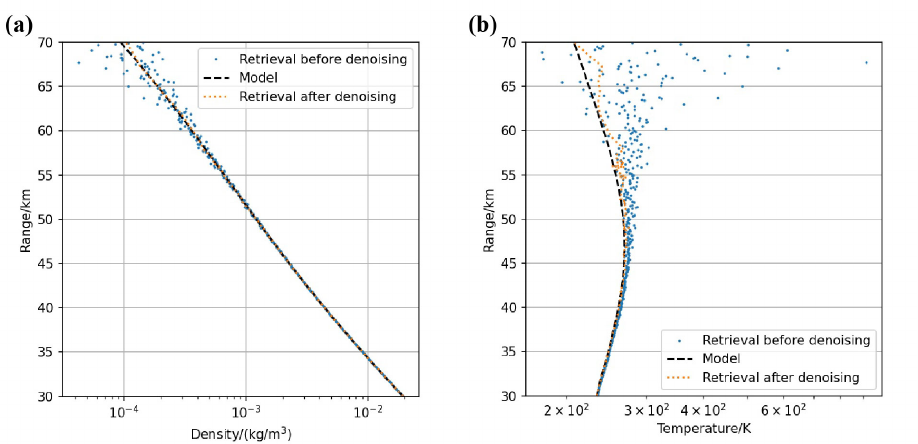
Figure 7. The variation of ( a ) density and ( b ) temperature retrievals with WT-EEMD-LOWESS algorithm.